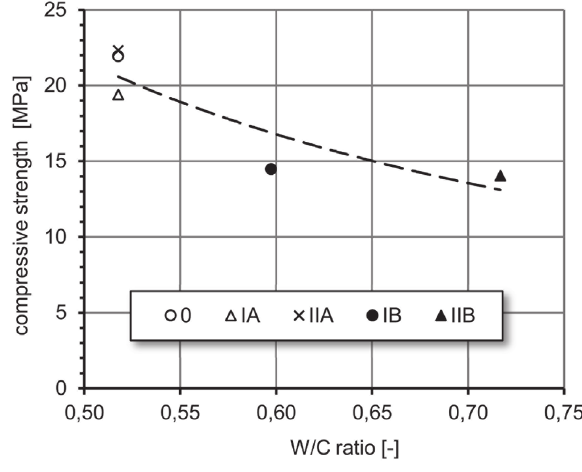
Figure 9: Strength of expanded clay aggregate concrete for reference specimens depending on water–cement ratio.